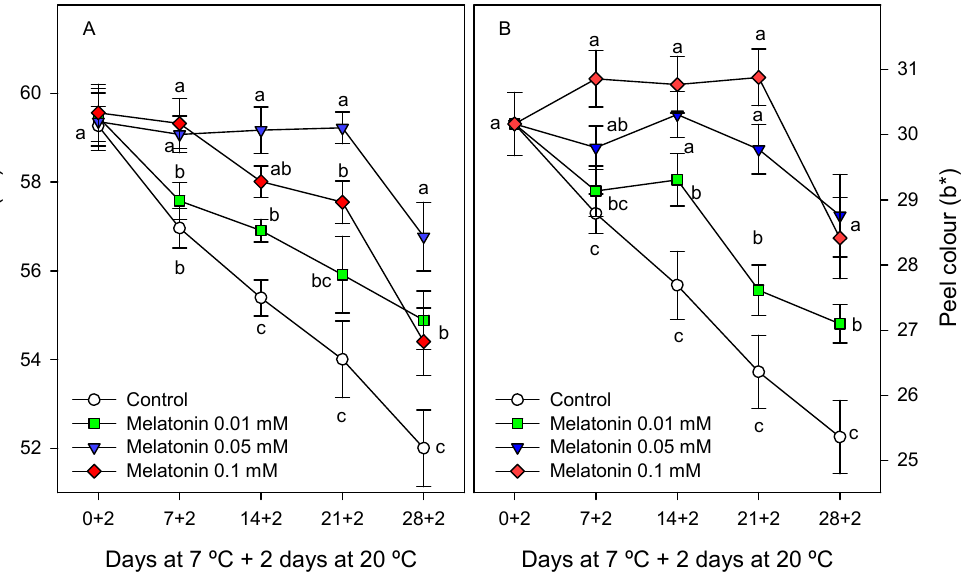
Figure 2. L* ( A ) and b* ( B ) colour parameters in cherimoya peel as affected by melatonin (0.01, 0.05 and 0.1 mM) treatments. Data are the mean ± SE of three replicates. Different letters show significant differences ( p < 0.05) among treatments for each sapling date.